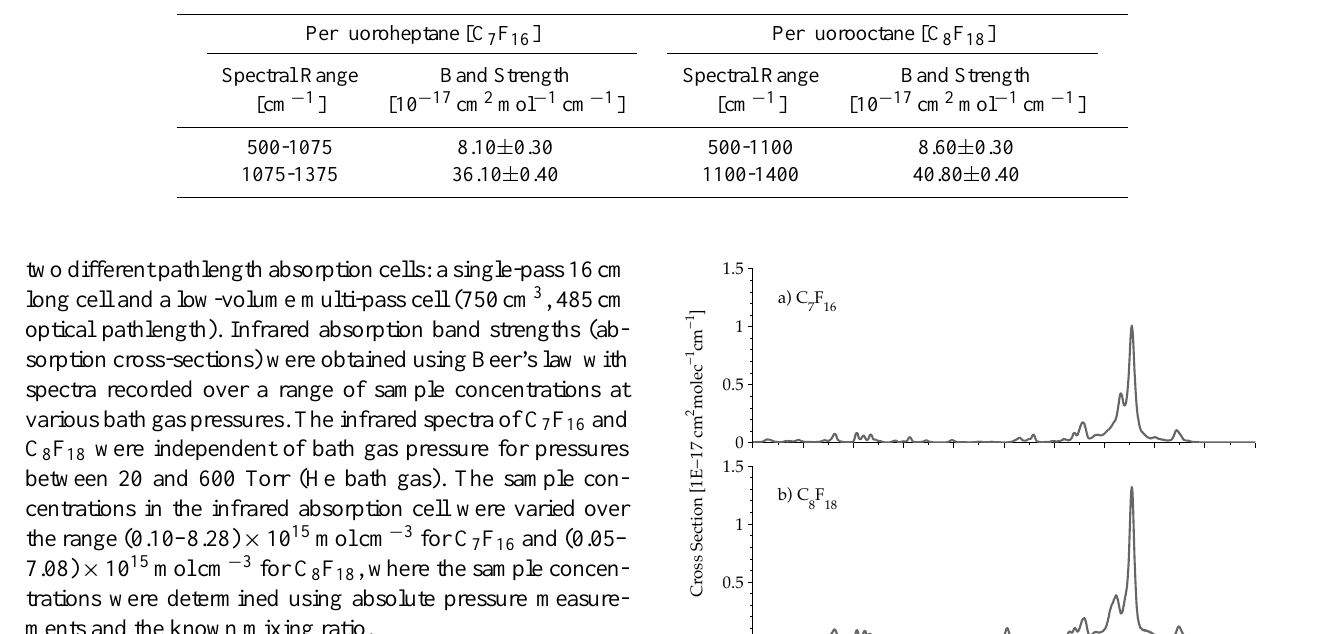
Table 2. Infrared Absorption Band Strengths for C 7 F 16 and C 8 F 18 at 296K.